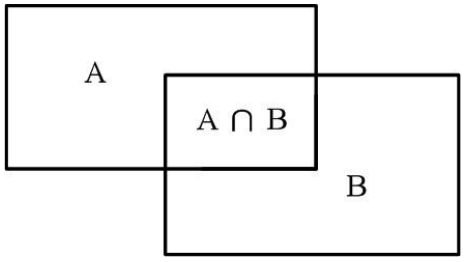
Figure 3. The schematic diagram of intersection-over-union (IoU).